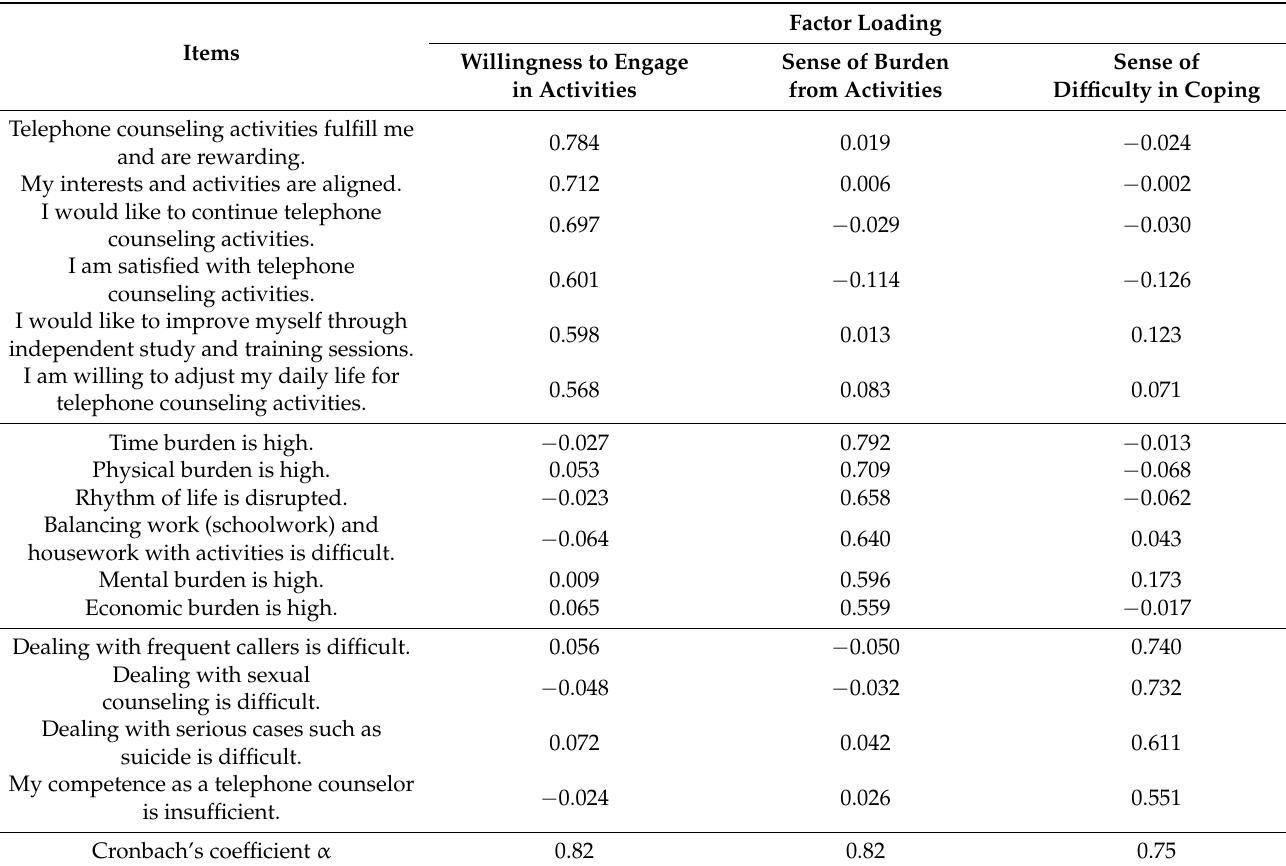
Table 3. Factor analysis on “thoughts on telephone counseling activities”.